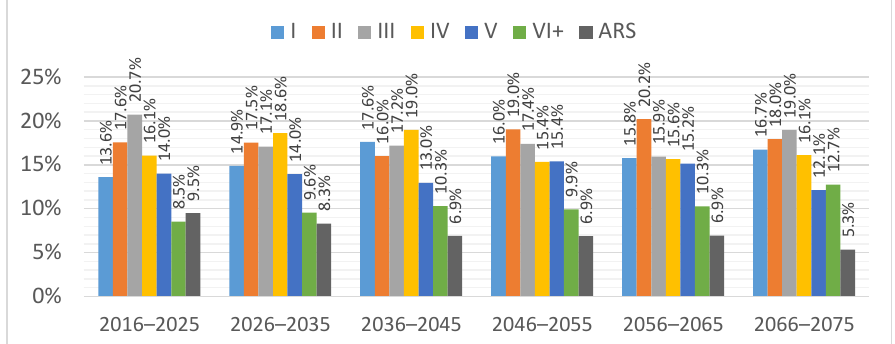
Figure 1. Anticipated changes in the structure of age classes area in the period 2016–2075 following today’s rules. (ARS—Actually Regenerating Stands).